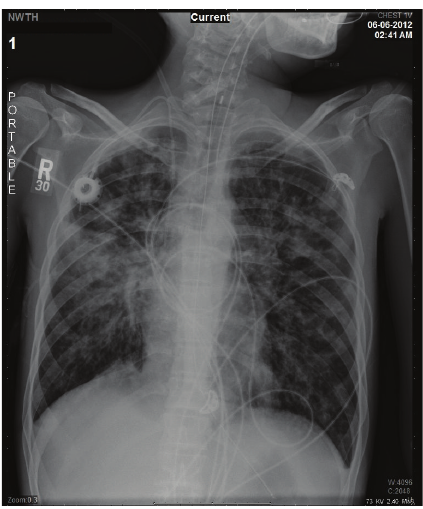
Figure 2: Chest X-ray on ICU admission.